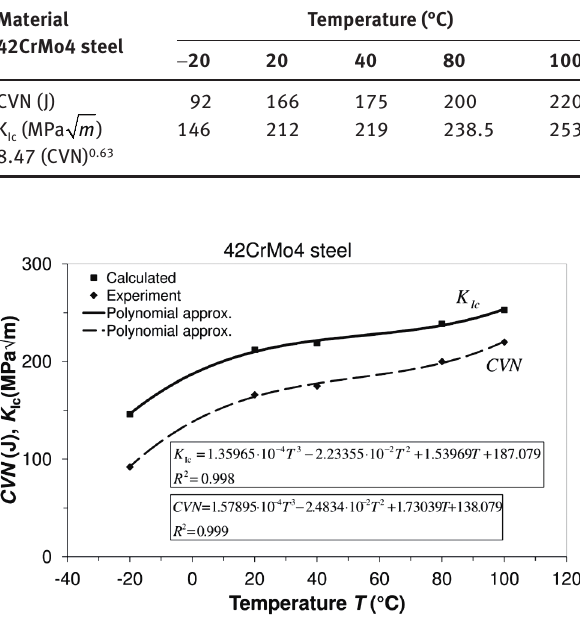
Fig. 10: Charpy impact energy and calculated fracture toughness versus